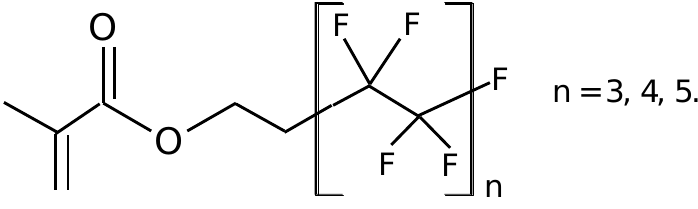
Figure 4. Molecular structure of perfluoro-acrylic oligomers.